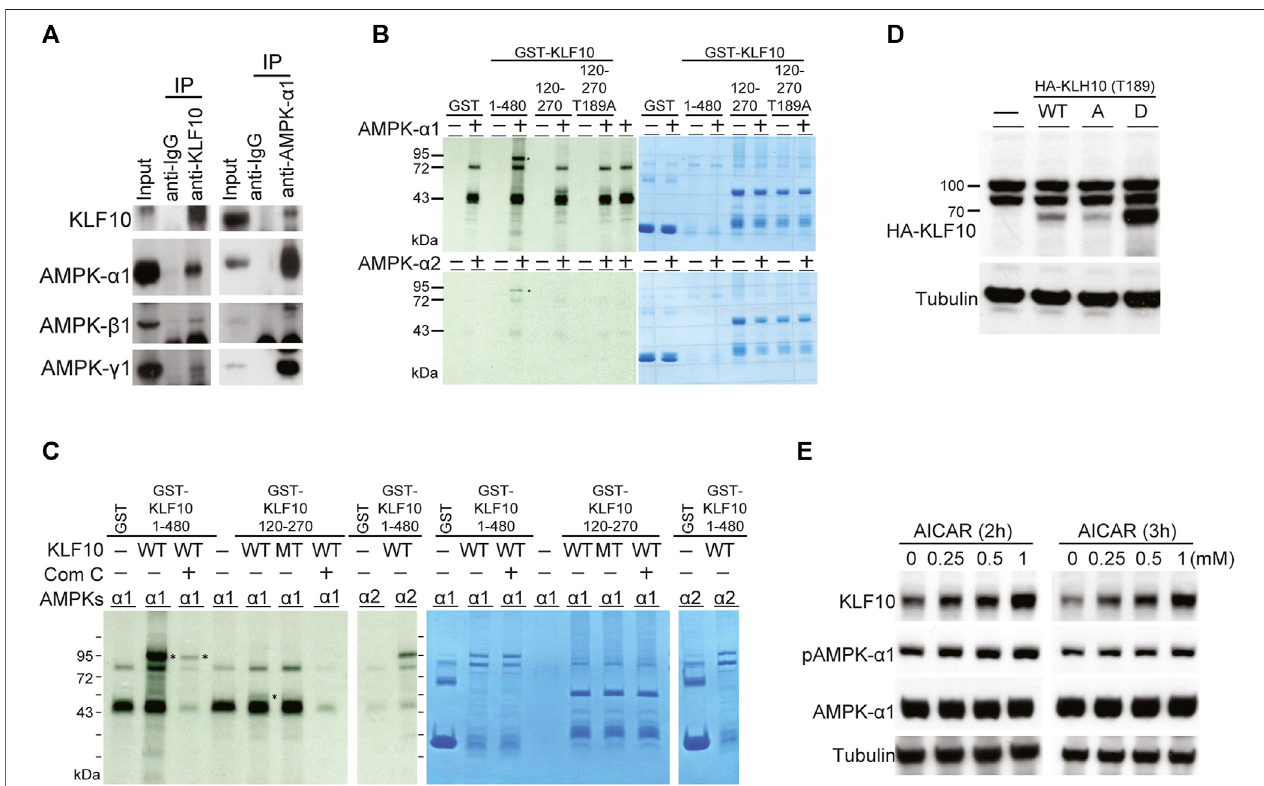
FIGURE 2 | KLF10 associated with AMPKs in in vivo and in vitro studies. (A) Immunoprecipitation was performed with extracts of HepG2 cells using either anti(a)-KLF10 or normal mouse immunoglobulin as the negative control. Precipitates were identi fi ed using a-KLF10, and the association was detected NGA-AMPK α 1, β 1, and c 1. (B) The in vitro association of AMPK α 1 and α 2 with KLF10 was analyzed via GST retention. Flag-tagged AMPKs were individually transfected into HepG2 cells for 24 h. Proteins retained on Sepharose were then subjected to Western blotting by using an a - fl ag antibody. (C) HepG2 cells expressing GST – KLF10 with overexpression of AMPK α 1 or α 2 were treated compound C for 16 h. The cell lysates were then precipitated with anti-KLF10 and analyzed by Western blotting using anti-GST antibodies. (D) HepG2 cells were transiently transfected with pRK5- fl ag-KLF10 wild-type, Thr189A, or Thr189D for 24 h and then analyzed by Western blotting. (E) HepG2 cells pretreated with 0.25 – 1 μ M AICAR for 2 and 3 h then the KLF10 levels were detected and quanti fi ed using tubulin as the loading control. The relative KLF10 levels were compared to the 0 h